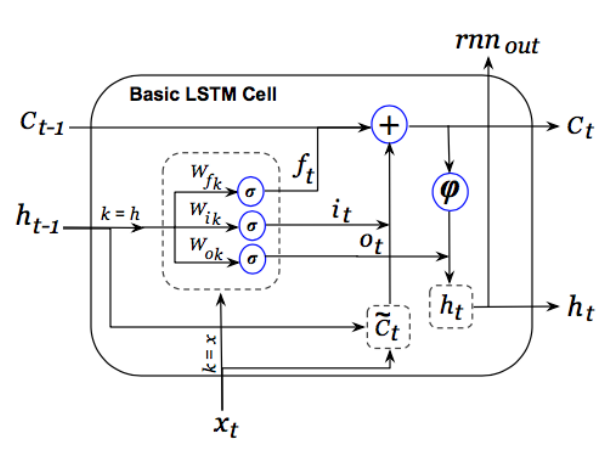
Figure 4. Basic Long Short Term Memory cell.